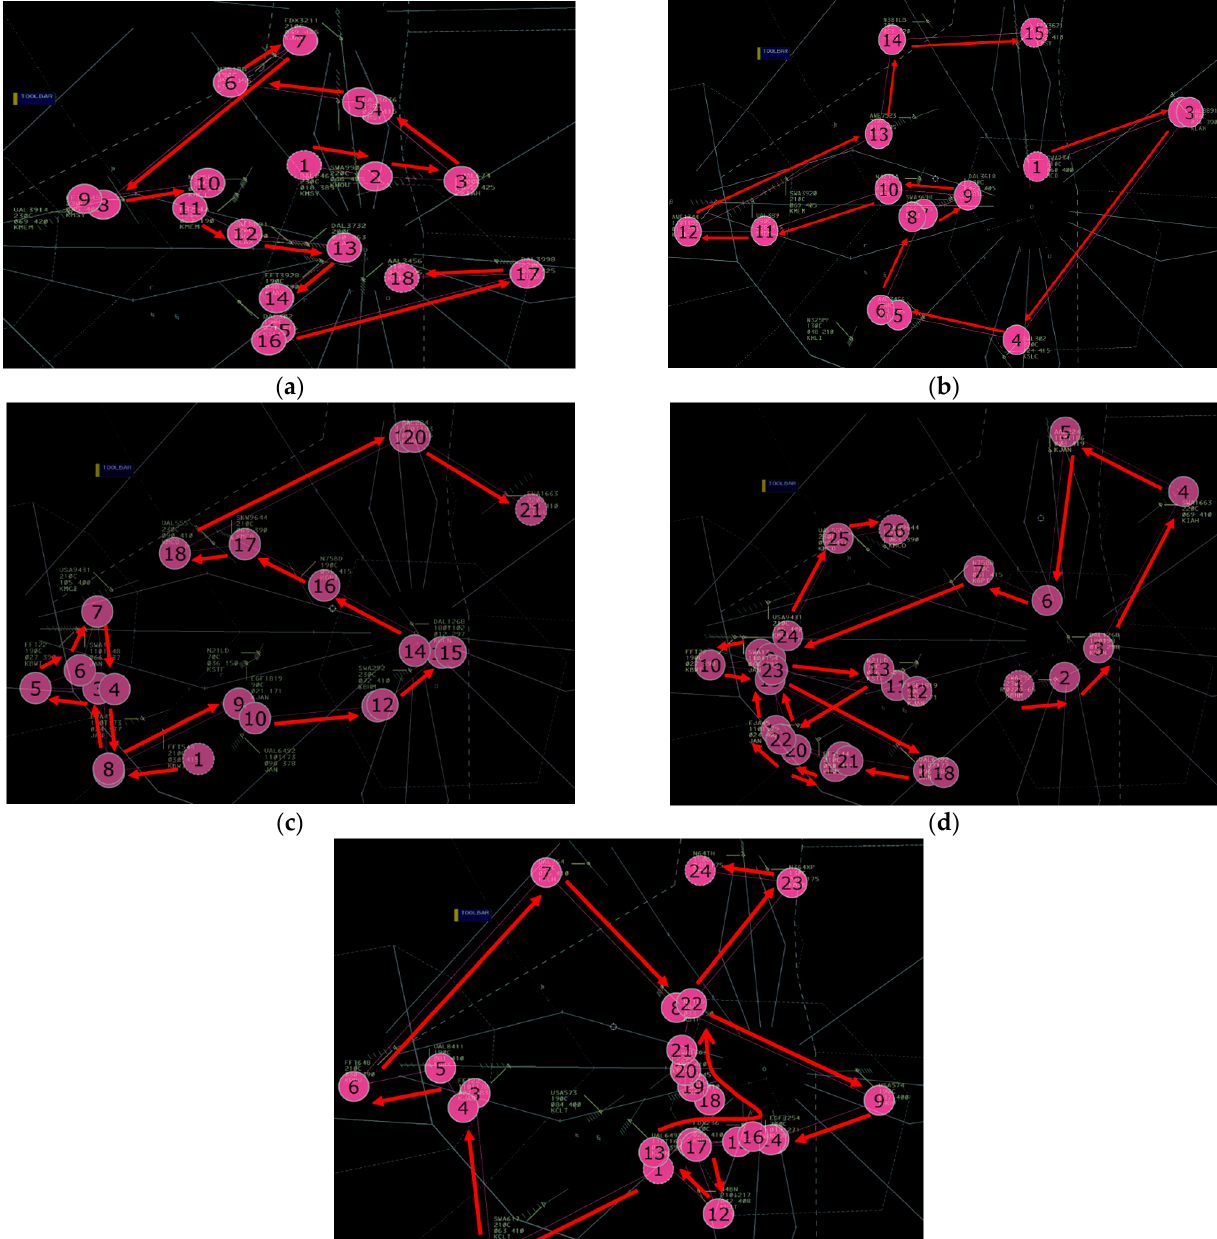
Figure 5. Representative examples of visual search strategies. ( a ) Spiral; ( b ) Circular; ( c ) Linear; ( d ) Quadrant, delineated by dashed yellow squares; ( e ) Mixed.